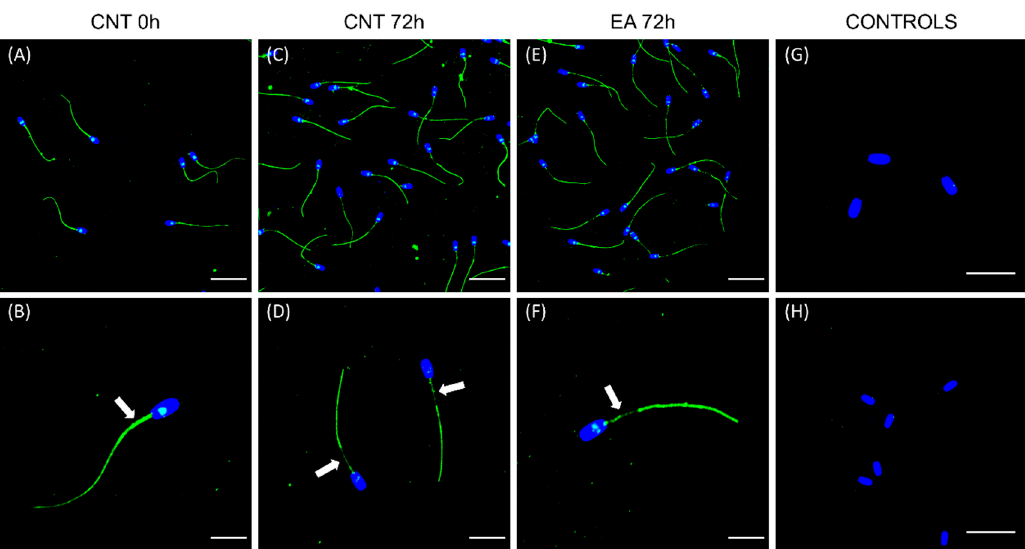
Figure 5. Immunolocalisation of sperm GSTM3. ( A, B ) control group at 0 h of storage at 17 °C, ( C, D ) control group at 72 h of liquid-storage, ( E, F ) Ethacrynic acid (EA)-treated spermatozoa at 72 h of liquid-storage, ( G ) negative control, and ( H ) peptide competition assay. White arrows indicate the sperm midpiece. The nucleus is shown in blue colour (DAPI), whereas GSTM3 is shown in green (fluorescein isothiocyanate, FITC). Scale bars: A, C, E, H: 30 μ m; D, G: 15 μ m; B, F: 10 μ m.